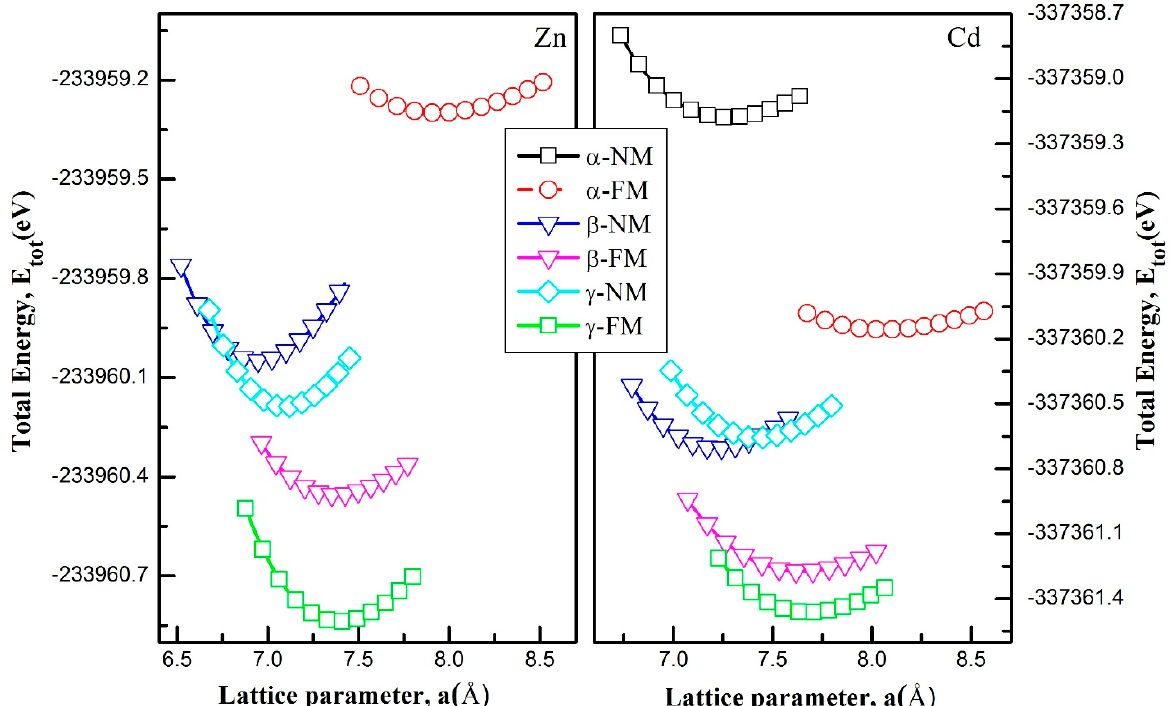
Figure 2. Variation of the energy as a function of the volume for RbNbCd and RbNbZn.